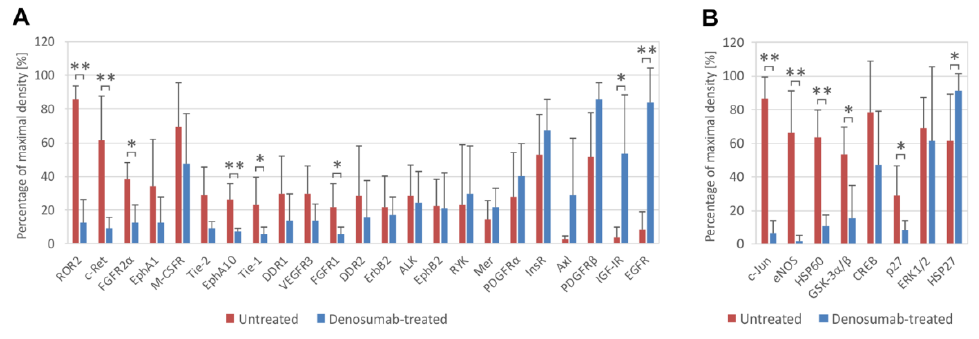
Figure 2. Phosphorylation analysis of RTKs and downstream signaling proteins in ten fresh-frozen GCTB samples (untreated, n = 5; denosumab-treated, n = 5). Highly phosphorylated RTKs ( A ) and downstream signaling proteins ( B ) are displayed. The cutoff level was set as 20% of maximal density. Phosphoproteins are arranged in order of differences between denosumab-treated and untreated samples. The data represent the mean ± SD. * p < 0.05, ** p < 0.01, indicating a significant difference between experimental groups.